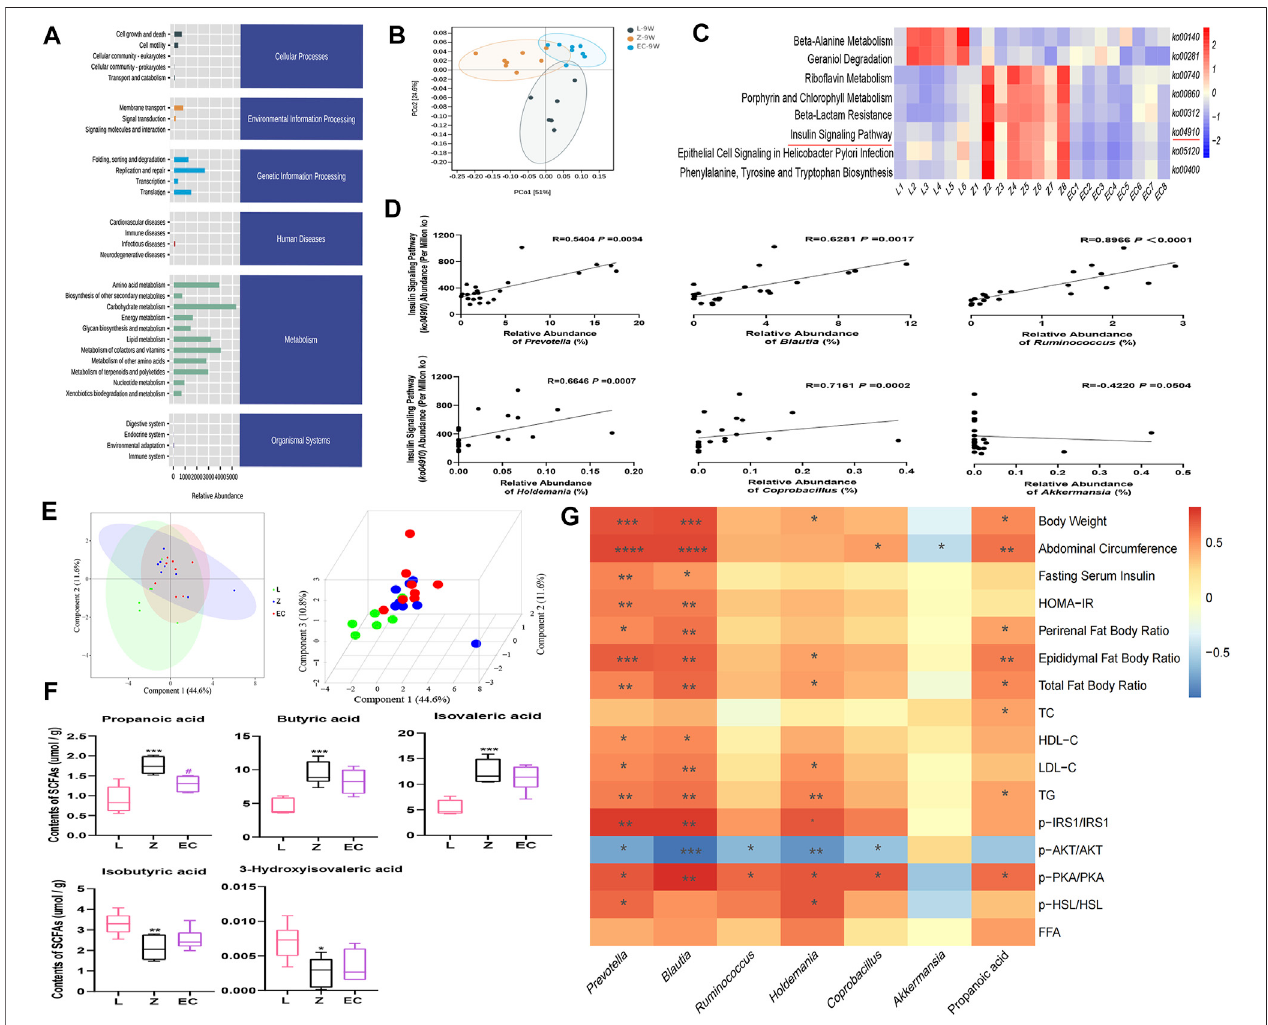
FIGURE6| ECDregulatedthefunctionofgutmicrobiota inZDF rats. Allthree groupswereat 9 weeksofage. (A) Theabundance ofKEGGfunctionalpathways at the secondary classi fi cation level of gut microbiota. (B) PCoA of gut microbiota functional units based on Bray-Curtis similarity. The ellipse con fi dence was 0.95. (C) Different metabolic pathways of gut microbiota. The intensity of colors represents the degree of association between gut microbiota and signaling pathways in each sample (red, strong correlation; blue, low correlation). (D) Correlation analysis between Prevotella , Blautia , Ruminococcus , Holdemania , Coprobacillus , Akkermansia , and the insulin signaling pathway ( ko04910 ). (E) 2D and 3D PLS-DA of SCFAs. (F) Contents of propionic, butyric, isovaleric, isobutyric, and 3- hydroxyisovaleric acid in cecal contents. The differences were analyzed by one-way ANOVA (Z vs. L, * p < 0.05, ** p < 0.01, *** p < 0.001; EC vs. Z, # p < 0.05). (G) Correlation between microbial and SCFA biomarkers and host phenotype. The panel shows the associations of six different genera and propionic acid with obesity, IR and lipid metabolism disorder phenotypes, and expression of the IRS1/AKT/PKA/HSL signaling pathway. Color intensity represents the degree of association (red, positive correlation; blue, negative correlation). * p < 0.05, ** p < 0.01, *** p < 0.001, **** p < 0.0001. Except (F) n (cid:2) 5 – 8, the rest n (cid:2) 6 – 8.